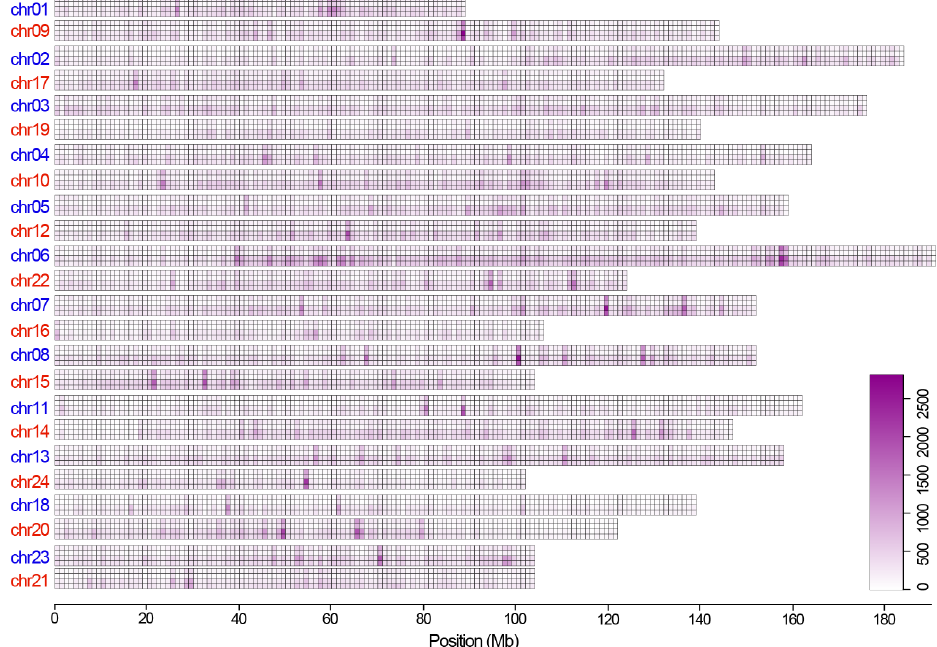
Figure 1. Genomic/chromosomal landscape of the genetic variants identified in the three pooled ginseng callus-regenerated plantlet samples. The four rows from top to bottom for each chromosome are genetic variants identified in samples y_2016_1, y_2016_2, y_2017, and de novo genetic variants. The numbers of the four types of Ht SNPs are the same as in Table 1. Homeologous chromosomes of the two ginseng subgenomes are labeled in blue and red, respectively.